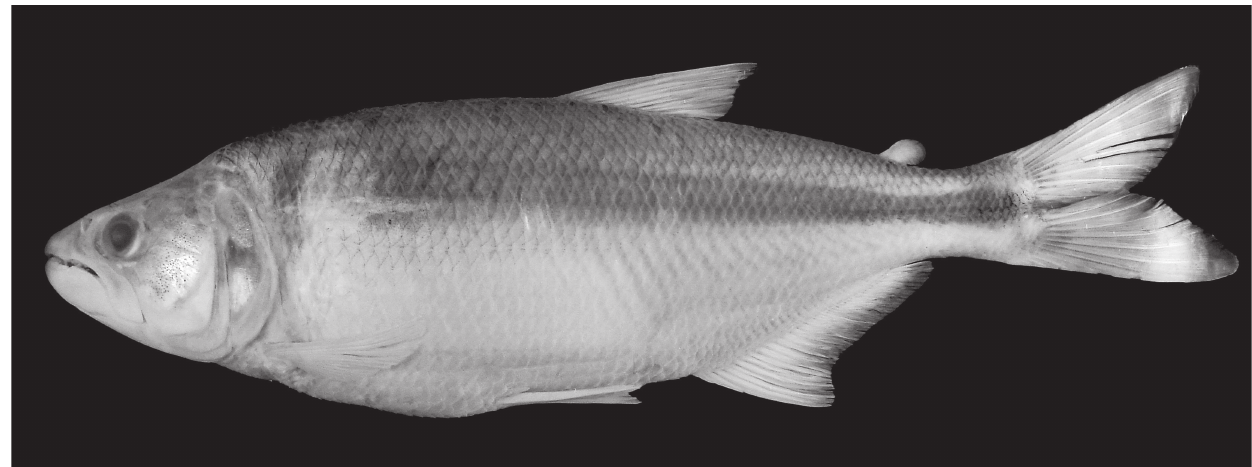
Fig. 1. Oligosarcus varii , holotype, MCP 31148, female, 184 mm SL, Brazil, Rio Grande do Sul, São Marcos, rio Jacuí